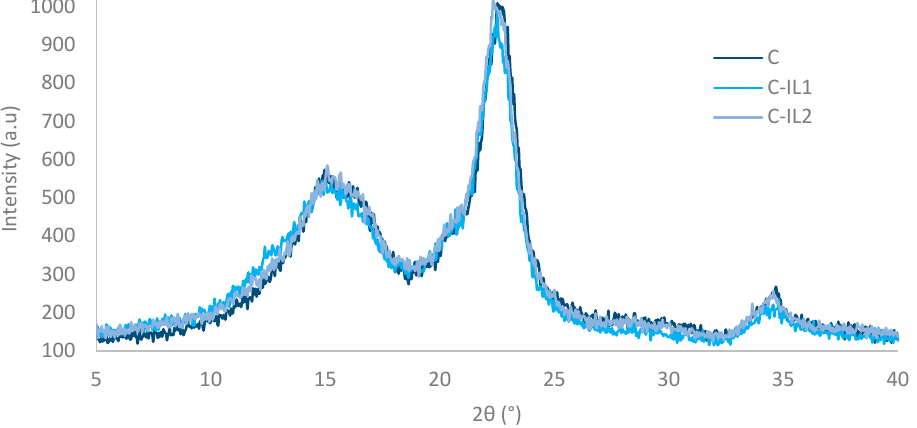
Figure 1. X-ray diffractograms for nanocellulose (C) and after functionalization with dimeric ionic liquids with shorter (C-IL1) and longer (C-IL2) alkyl linkers.